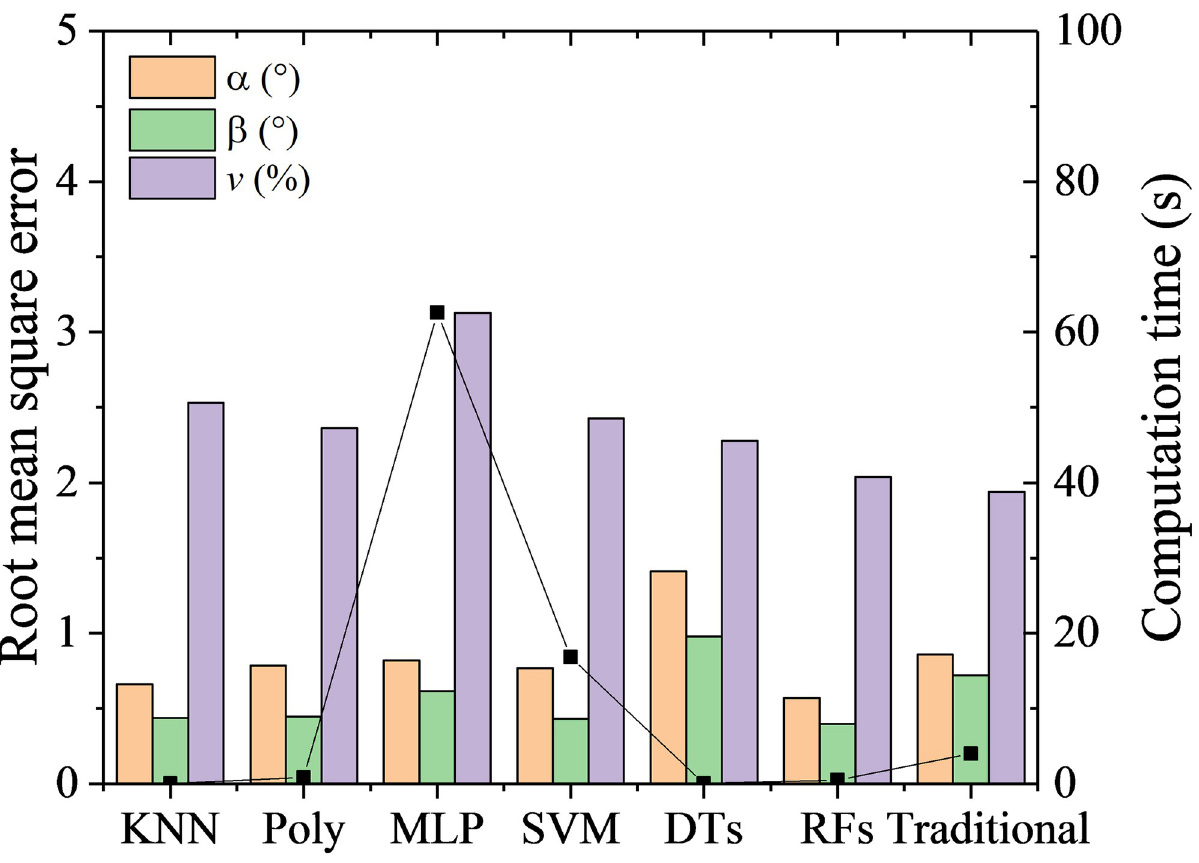
Fig 11. RMSEs and computation time with the six